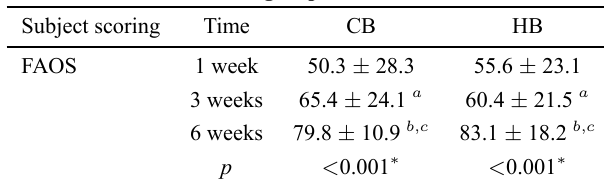
Table 2. FAOS score of the CB training and HB training